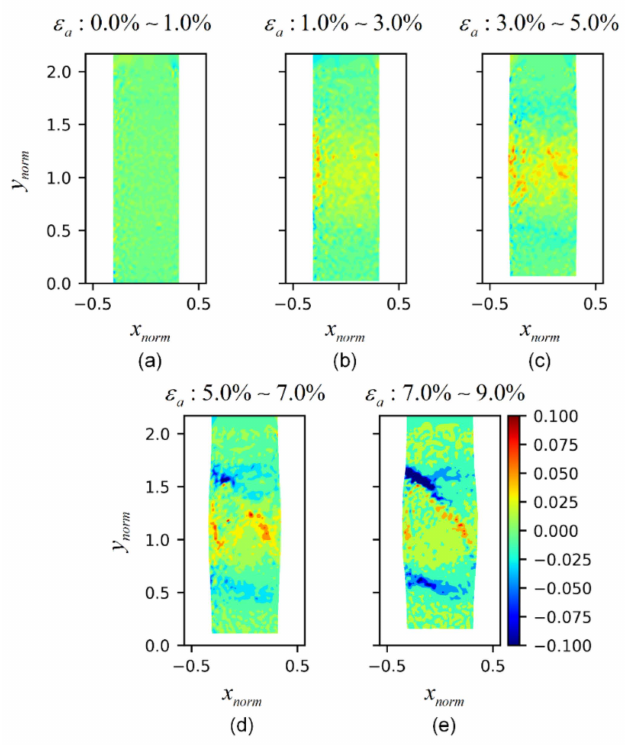
Figure 9. Evolution of divergence fields div U of test 092903b: ( a ) axial strain 0.0%–1.0%; ( b ) axial strain 1.0%–3.0%; ( c ) axial strain 3.0%–5.0%; ( d ) axial strain 5.0%–7.0%; ( e ) axial strain